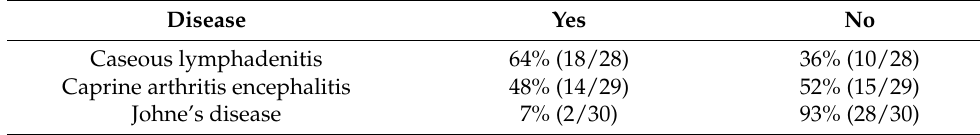
Table 5. Dairy goat producer responses to the question: has caseous lymphadenitis, caprine arthritis encephalitis or Johne’s disease ever been diagnosed on your